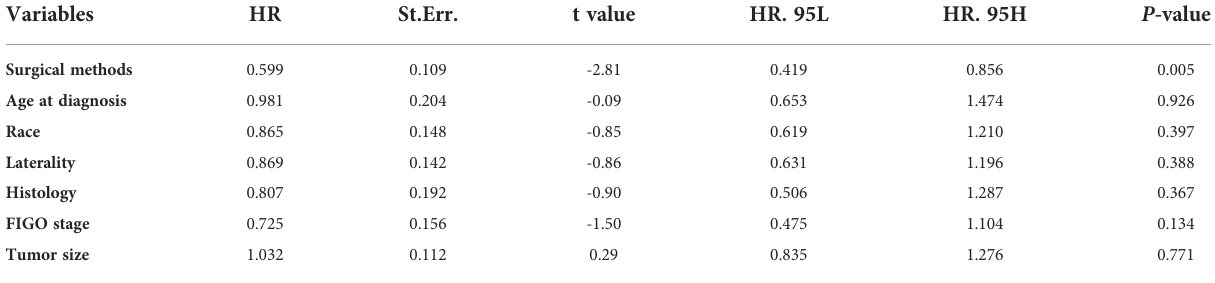
TABLE 3 Multivariable analysis of prognostic factors in patients with stage I SCSTs using the Fine-Gray model.